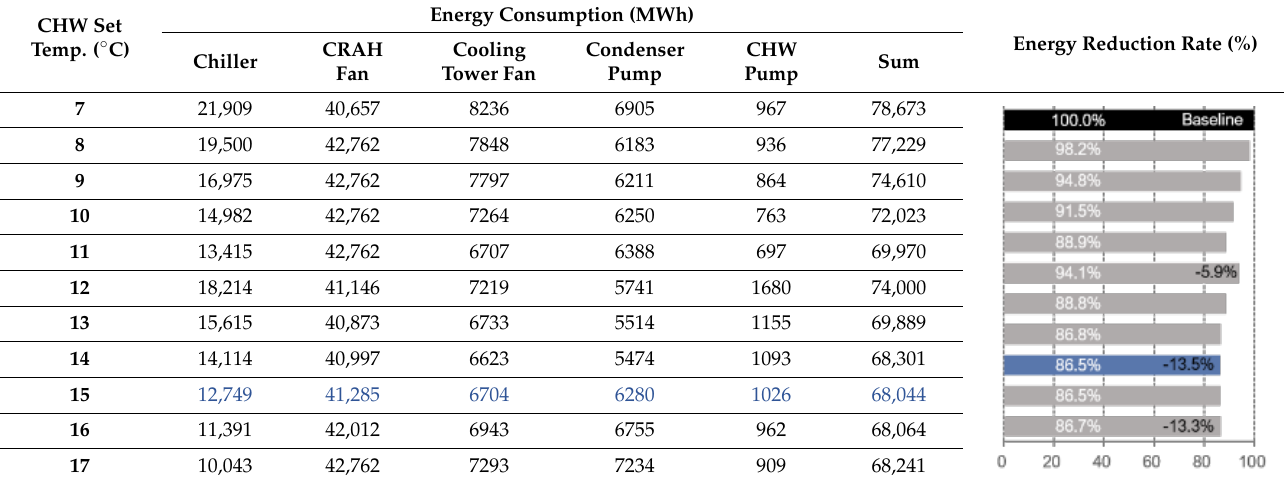
Table 5. Energy consumption for the application of WSE (type 4) with Δ T control with respect to changes in the chilled water set temperature. The value shown in blue indicates the optimum value among the set temperature of chilled water in the range of 7–17 ◦ C. CHW set temp. ( ℃